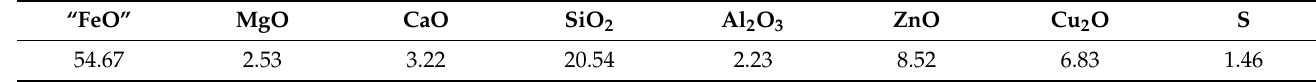
Table 1. Composition of the smelting slag measured by